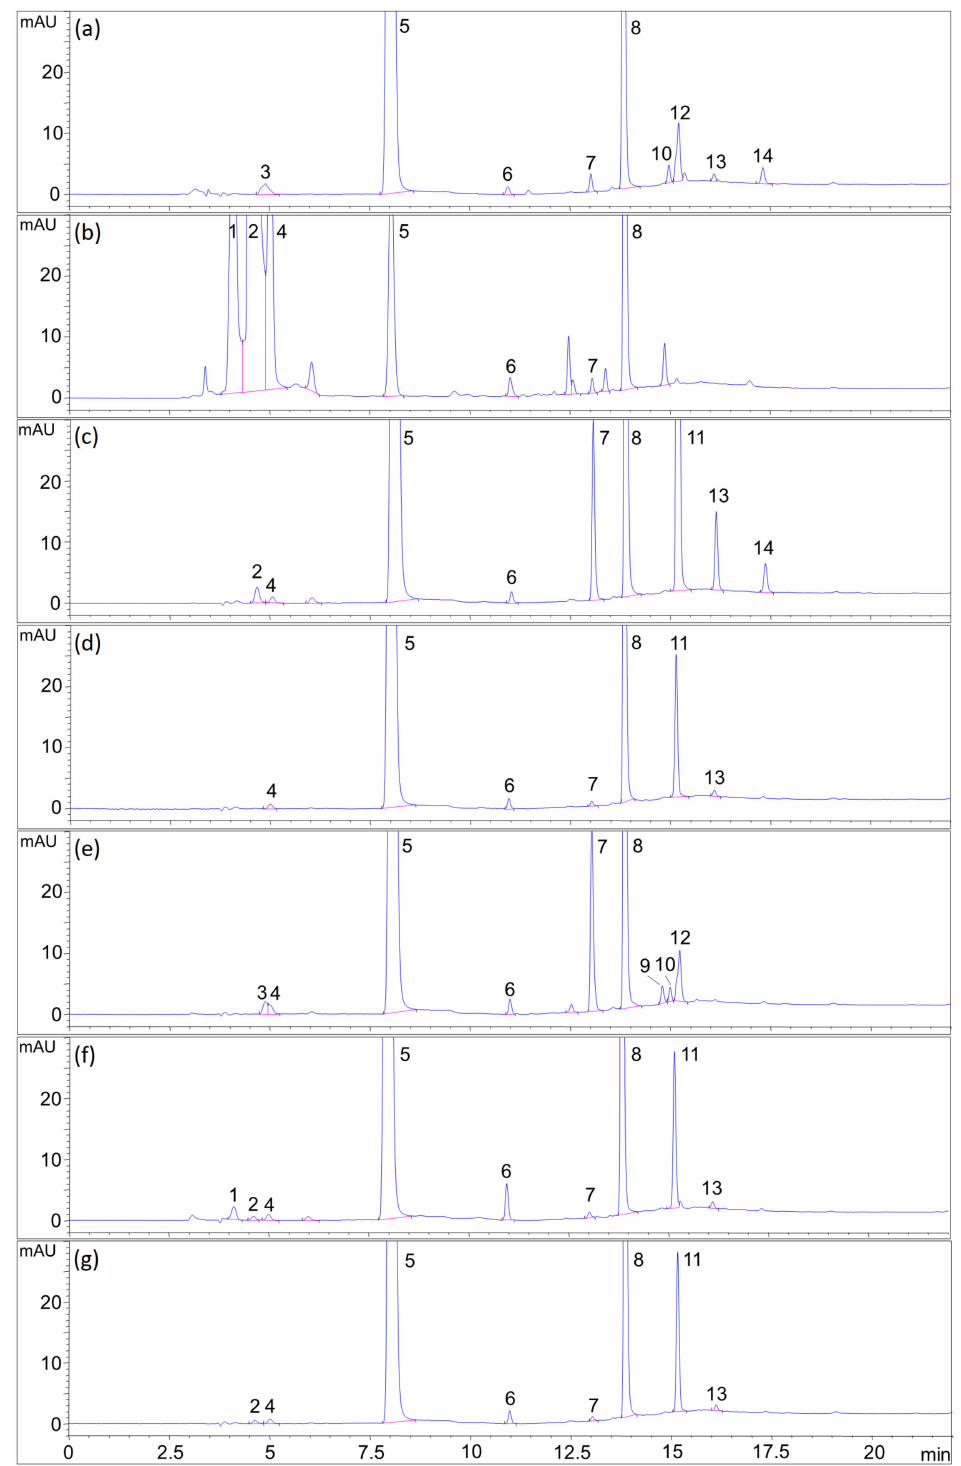
Figure 7. Forced degradation chromatograms of the formulation blend. ( a ) Acidic hydrolysis, ( b ) basic hydrolysis, ( c ) oxidative, ( d ) thermal (solid), ( e ) thermal (solution), ( f ) photolysis (solid) and ( g ) photolysis (solution). Legend: 6MP—5; FA—8; HX—4; pABGA—6; PA—9; 6MP degradants—1, 2, 7, 11, 13 and 14 and FA degradants—3, 10 and